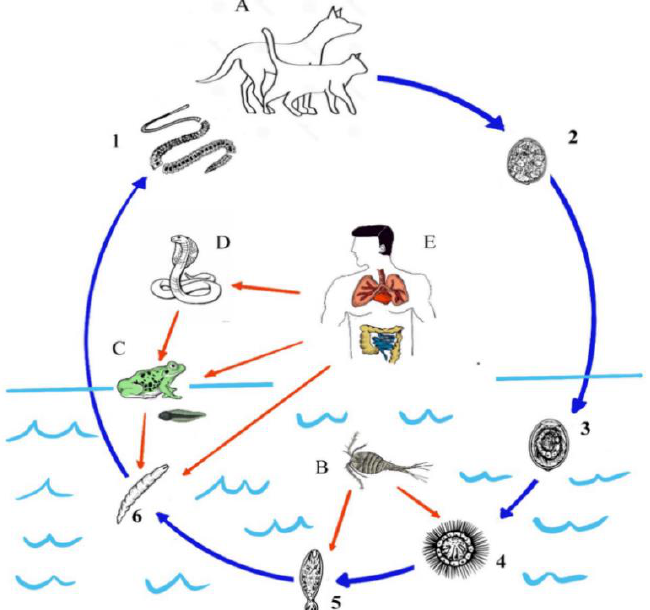
Figure 1. The life cycle of Spirometra tapeworm. 1: Spirometra adult worms; 2: eggs; 3: eggs hatch in water; 4: coracidia; 5: procercoid larvae; 6: sparganum: A: the definitive hosts: dogs and cats; B: the first intermediate hosts: cyclops; C: the second intermediate hosts: frogs and tadpoles; D, E: the paratenic hosts: human beings and snakes.